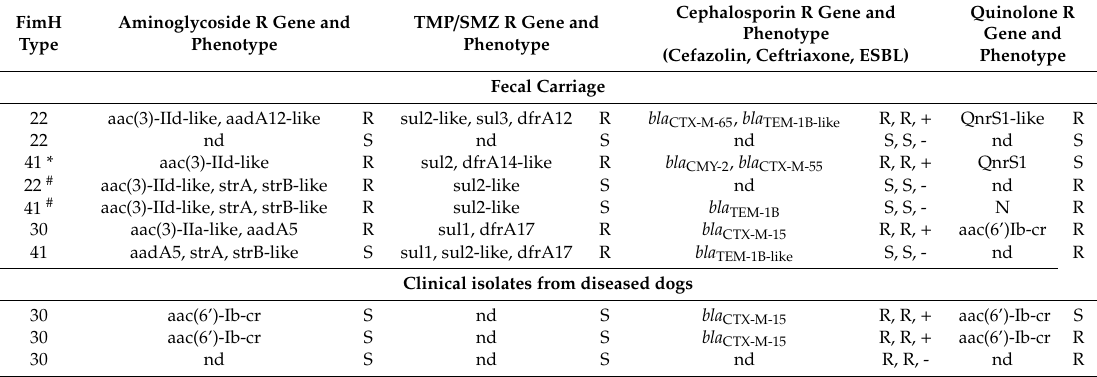
Table 3. The antibiotic resistance profiles (genes and phenotypes) of 7 fecal carriages of ST131 isolates and 3 clinical isolates from diseased